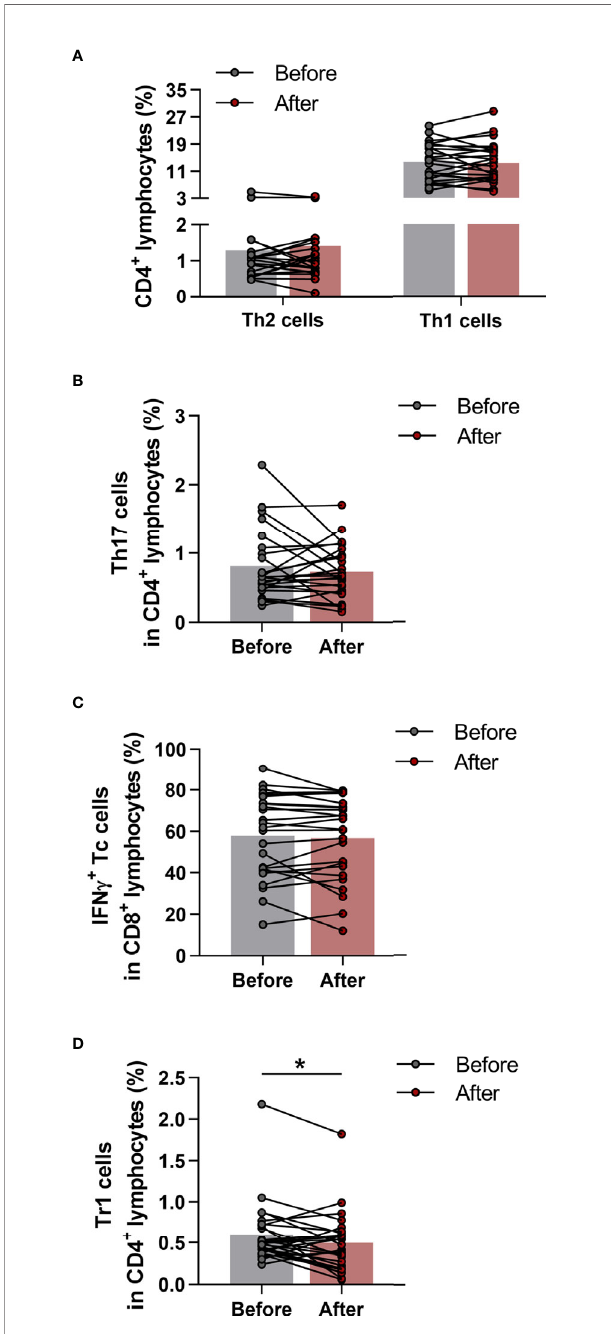
FIGURE 5 | Determination of T helper and T cytotoxic cells with intracellular cytokine analysis in elderly women before and after the exercise program. Whole blood of 29 healthy participants were stimulated for 5h and dyed with fl uorochrome-conjugated monoclonal antibodies with intracellular staining method as described previously. All cell subsets were quanti fi ed as their percentage in the CD4 + or CD8 + lymphocyte population. (A) Frequencies of IFN g + Th1 and IL-4 + Th2 cells. (B) Percentages of IL-17 + Th17 cells. (C) Ratio of IFN g producing Tc cell. (D) Proportions of IL-10 producing type-1 regulatory (Tr1) cells. Paired T test was used. Each data point represents an individual subject, while bars show the mean values. Statistically signi fi cant differences are indicated by *p <